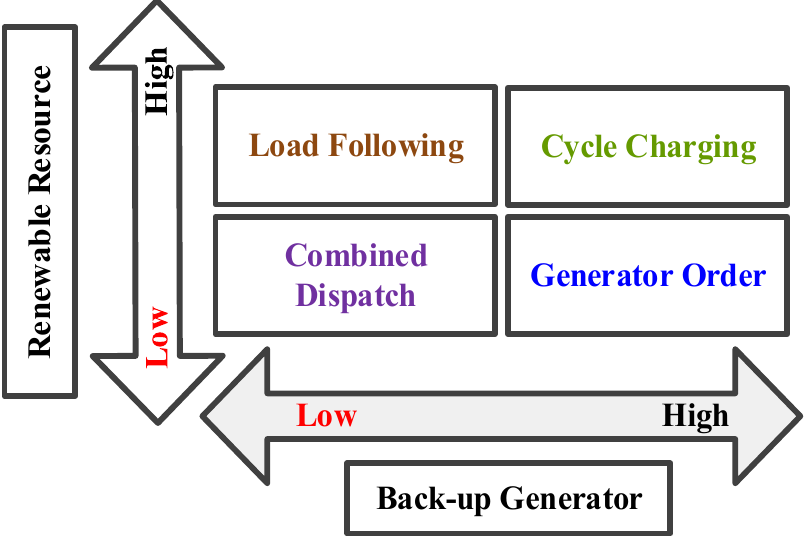
Figure 2. Impact of renewable resources and diesel engines depends on the different dispatch mechanisms for IHMS.